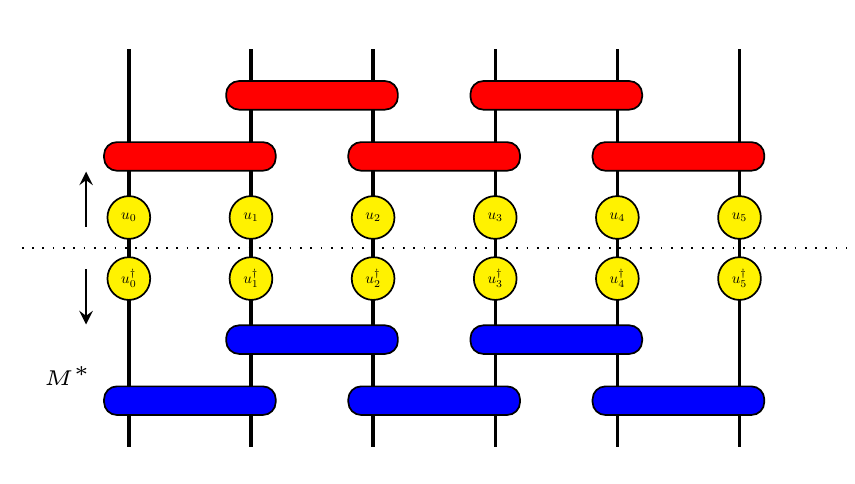
Figure 8: The gauge freedom that exists between the layers of a circuit. When we cut the circuit across the horizontal dashed line, and want to use the lowest M ∗ layers to calculate an infidelity, we have to take into account the gauge freedom that is encoded by inserting a pair of conjugate one-qubit unitaries u † and absorbing one unitary upwards and the other